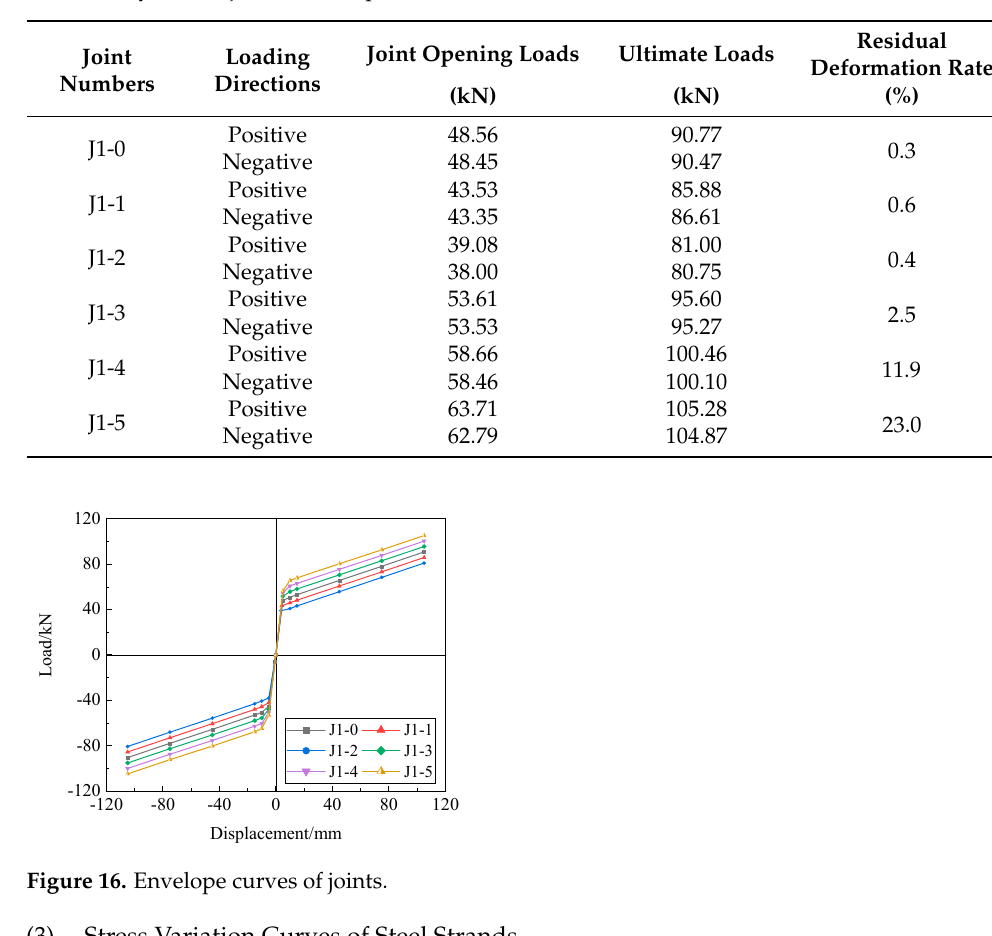
Table 4. Key data of joint load–displacement curves.